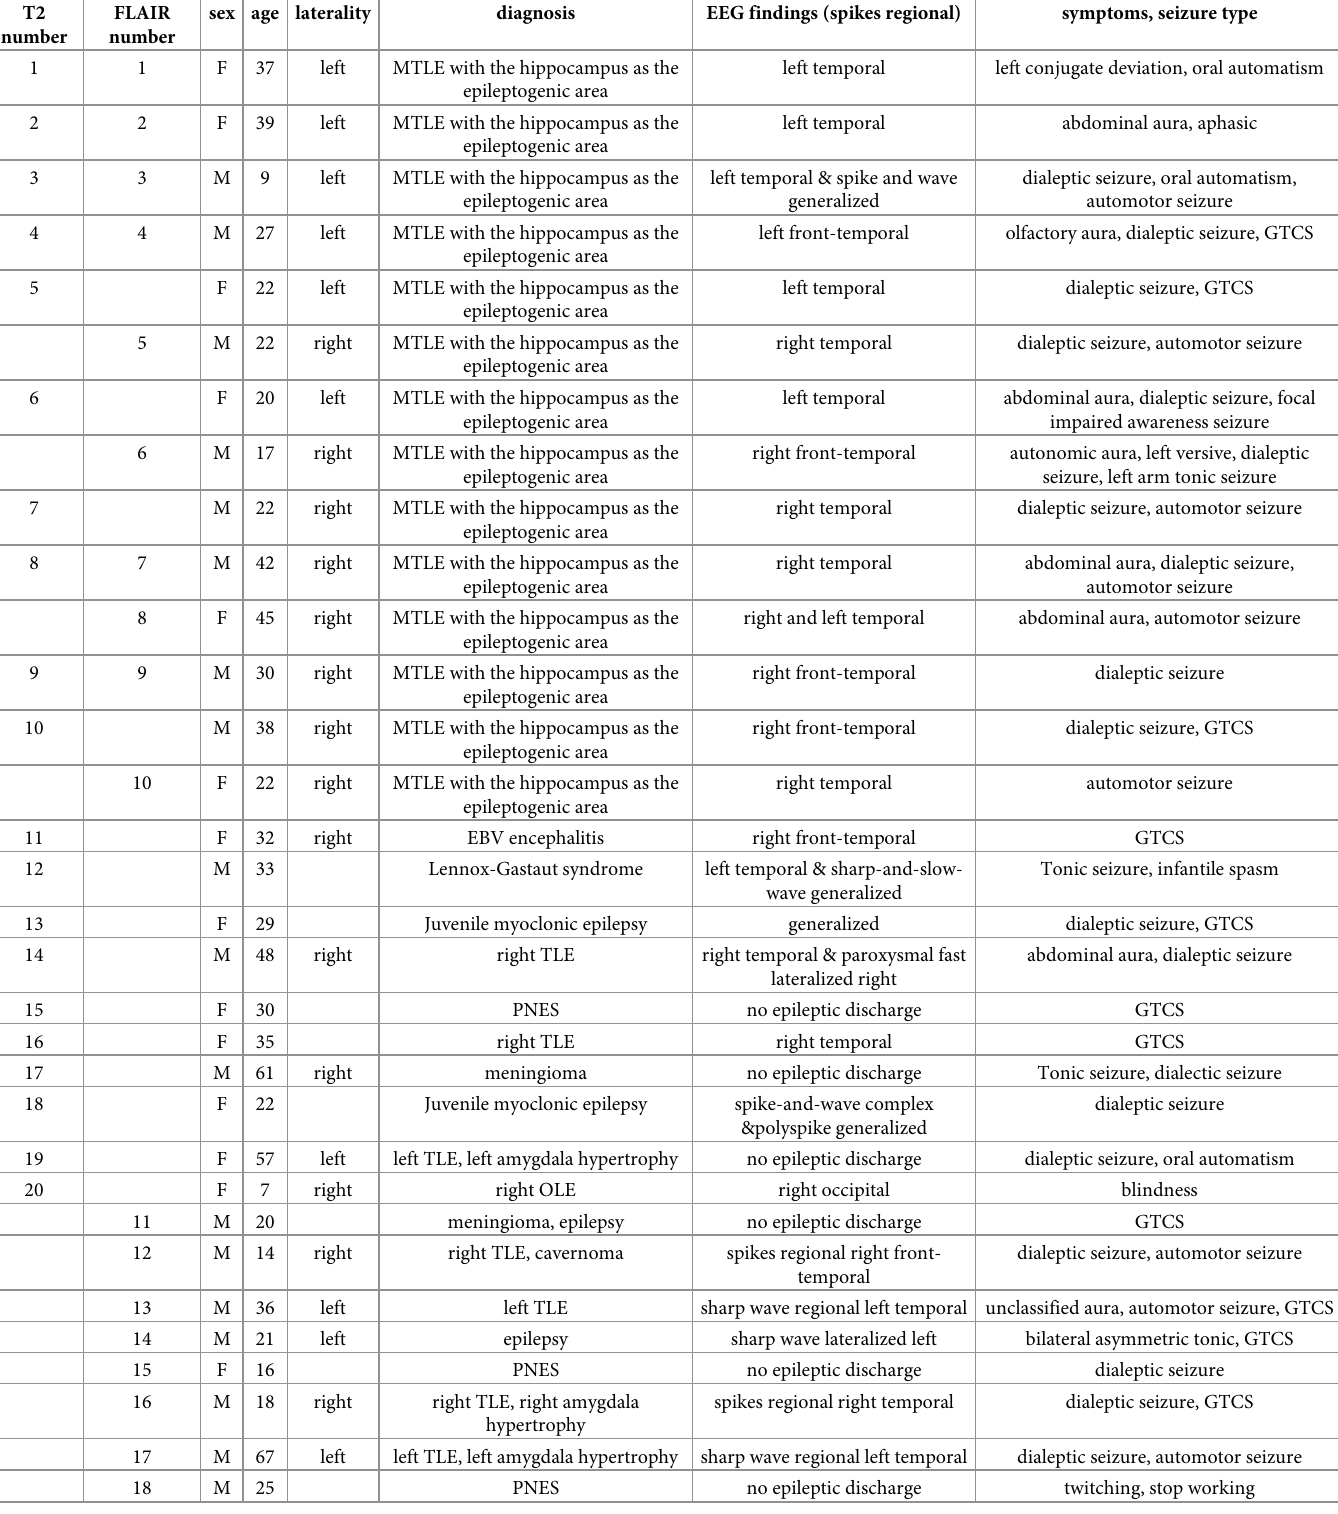
Table 3. Summary of the findings of the T2-weighted and fluid-attenuated inversion recovery images of the 20 patients. T2